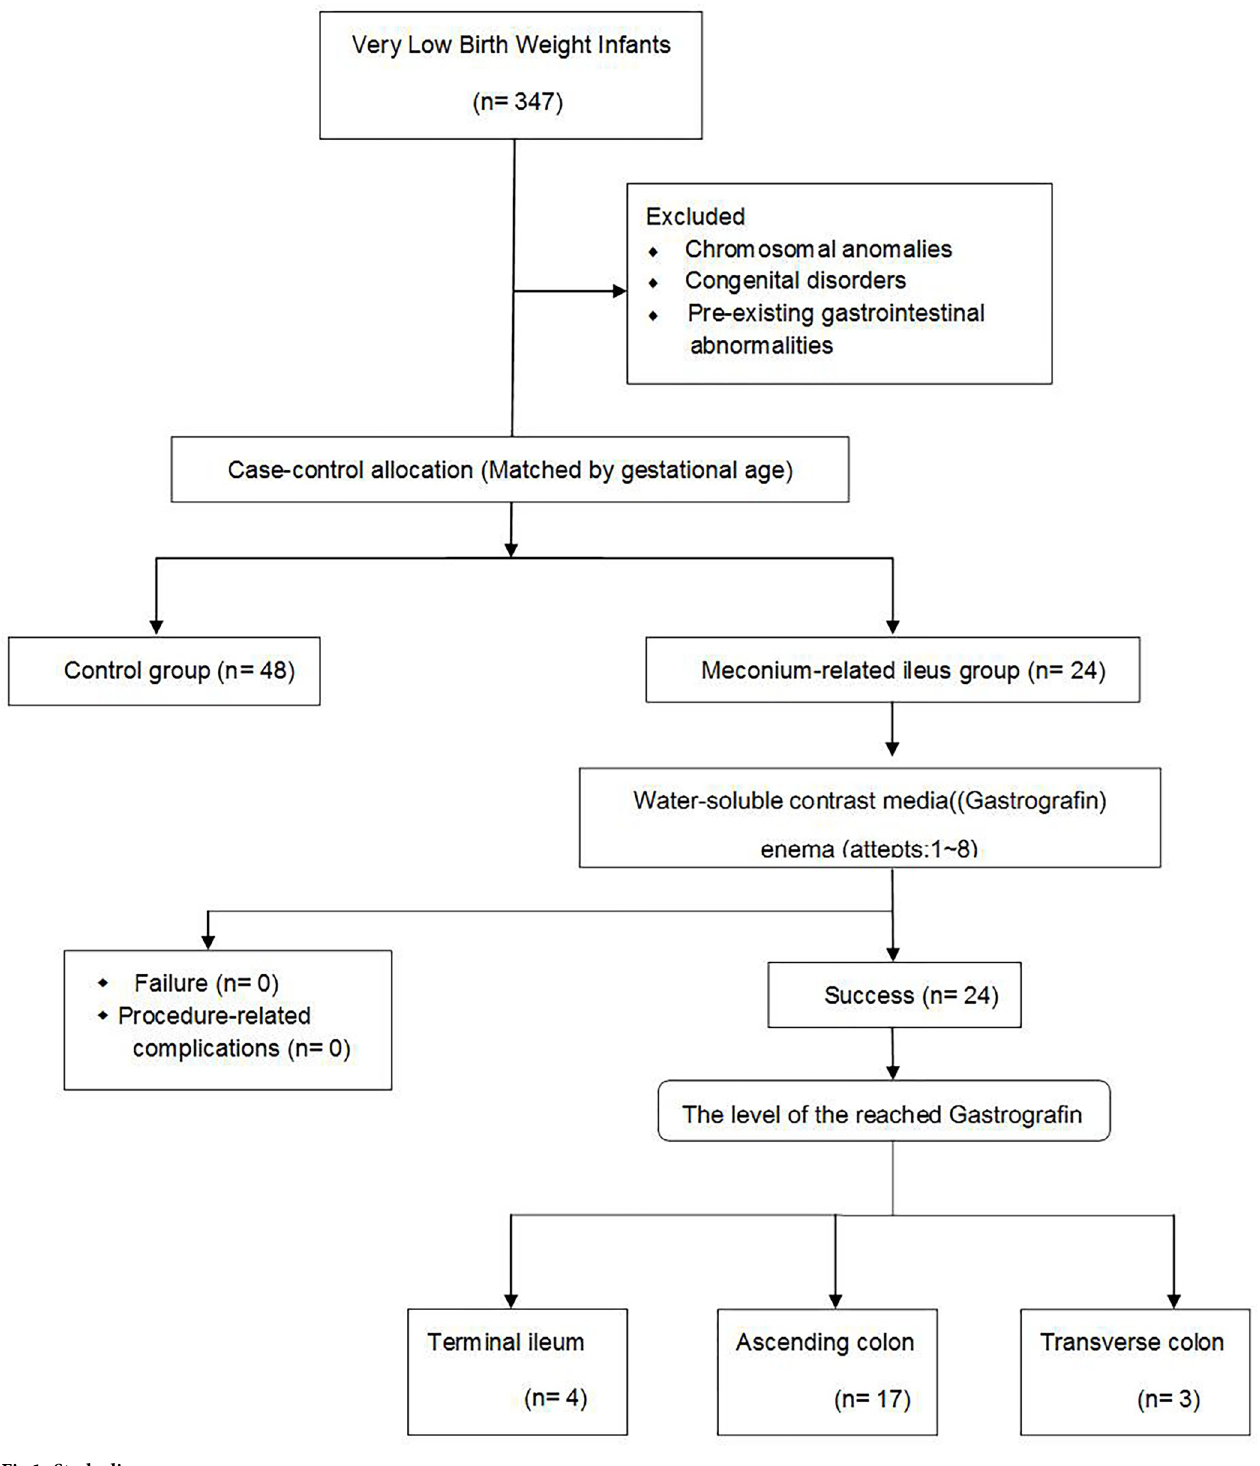
Fig 1. Study diagram.